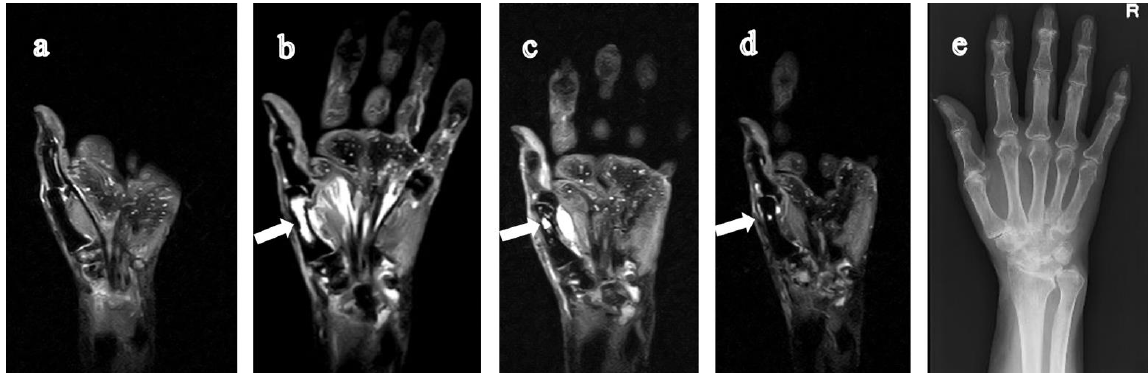
Figure 5. 67-year-old woman with rheumatoid arthritis for eight years. At the baseline ( a ), there was no abnormality in the 1st metacarpal bone of the right hand on coronal STIR. Nine months later, ( b ) a high signal lesion appeared. The lesion originated from the distal aspect of the 1st metacarpal bone of the right hand and extended to the central diaphysis with synovitis, tenosynovitis, and extraosseous cysts. After another six months, ( c ) the cystic lesions in the 1st metacarpal bone dramatically decreased in size. ( d ) The cystic lesions remained stable during the follow-up of six years. ( e ) The cyst lesion cannot be seen on CR throughout this period. RA, rheumatoid arthritis; STIR, short tau inversion recovery; CR, computed radiography.